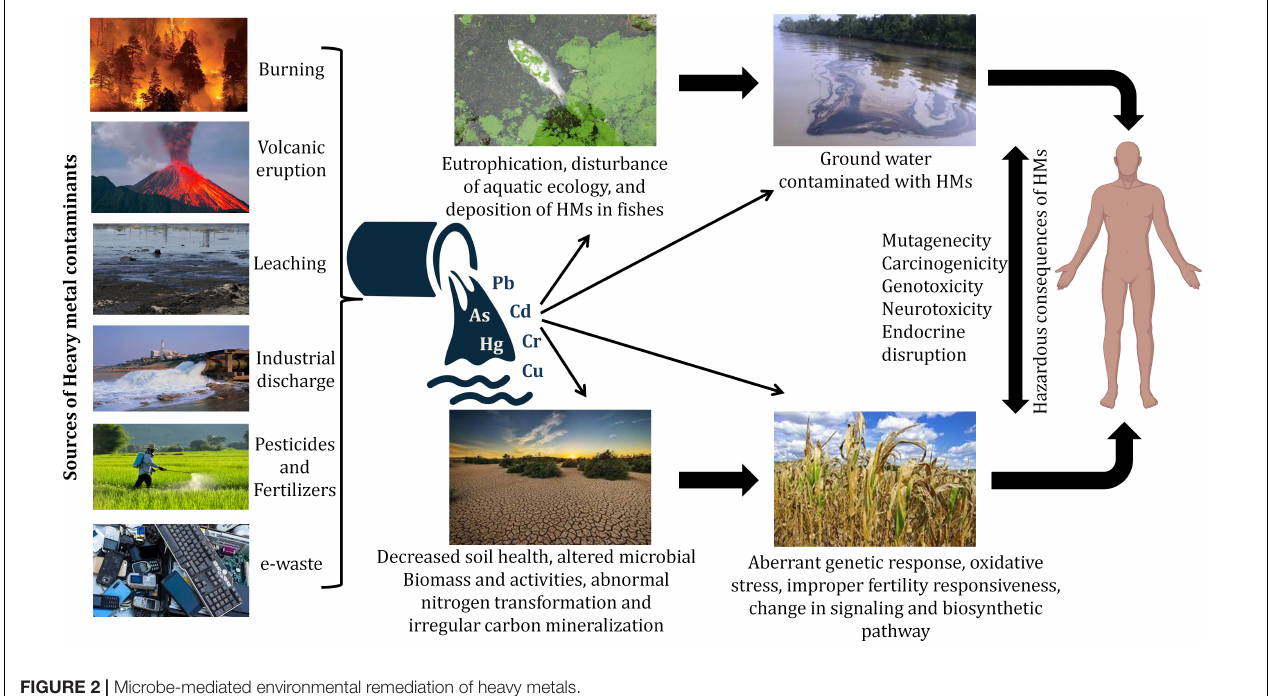
FIGURE 2 | Microbe-mediated environmental remediation of heavy metals. TABLE 2 | Microbe-mediated remediation and resistance mechanism of heavy